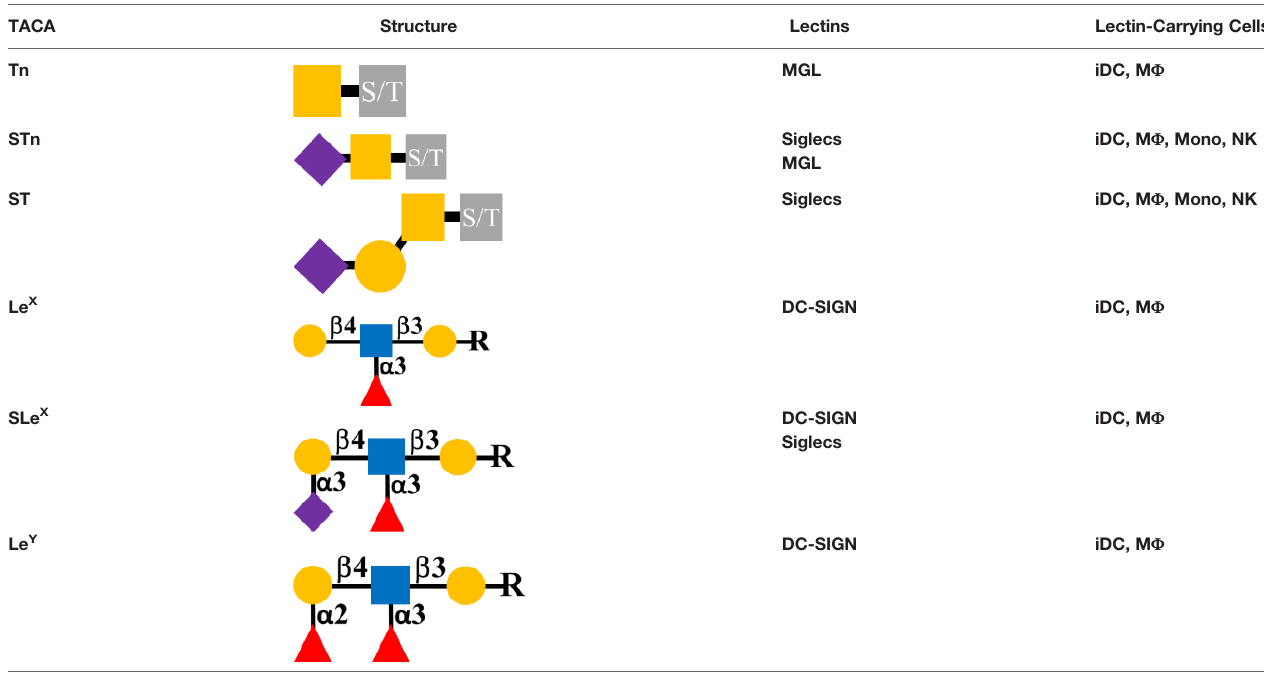
TABLE 1 | Colorectal carcinoma (CRC) tumor-associated carbohydrate antigens (ligands) and the lectin-binding cells Tumor-Associated Carbohydrate Antigens (TACA), Serine/threonine (S/T), N-acetyl-galactosamine ( ), Sialic Acid ( ), Galactose (